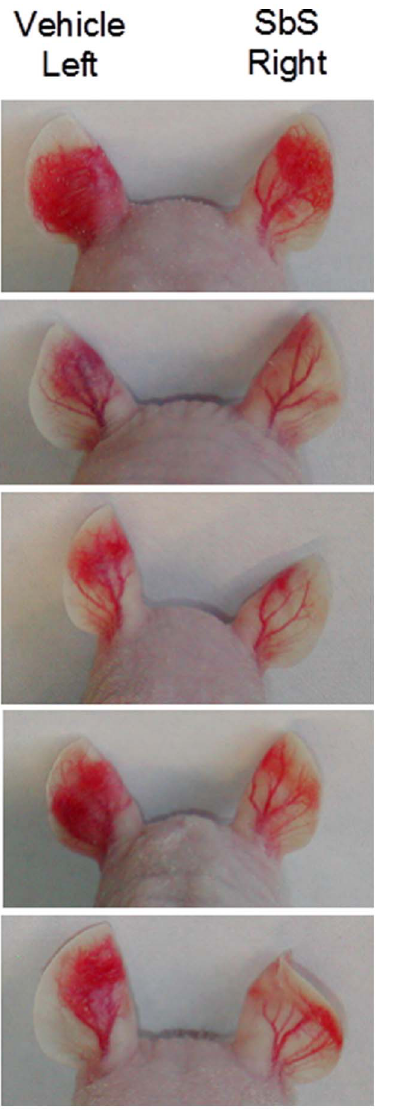
Figure 2. Sb inhibits VEGF-induced angiogenesis in the mouse ear vasculature model. The effects of Sb on VEGF-induced angiogenesis in vivo was assessed using an adenovirus expressing VEGF-A(164) (Ad-VEGF-A(164)) in the ears of adult nude mice (NuNu). Ad-VEGF-A164 (5 6 10 6 pfu) was injected into both ears. One hour later the right ears of mice (N=5) were injected s.c. with 10 m l SbS (ion- exchange chromatography enriched and DMEM diluted) and the left ears were injected s.c. with 10 m l vehicle (DMEM) as control. A second injection of SbS or vehicle was administered 24 hours later. Each of the 5 mice showed an angiogenesis response to Ad-VEGF-A164 in the control (left) ear. The inhibitory effect of SbS was evident with reduced new vessel formation in the right ear compared to the left. The images shown were obtained on day 16 after Ad-VEGF-A164 administration.